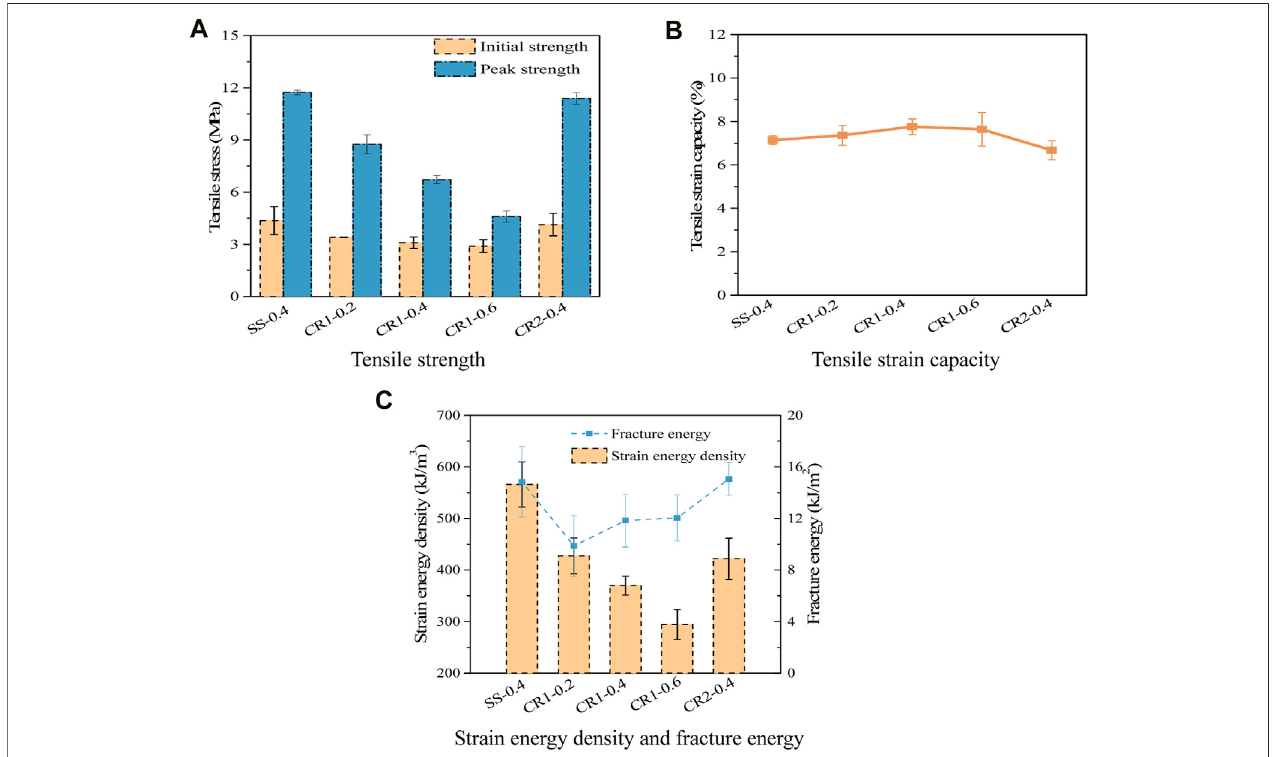
FIGURE 6 | Tensile mechanical parameters of HS-ECC. (A) Tensile strength. (B) Tensile strain capacity. (C) Strain energy density and fracture energy. HS-ECC, high-strength engineered cementitious composite.